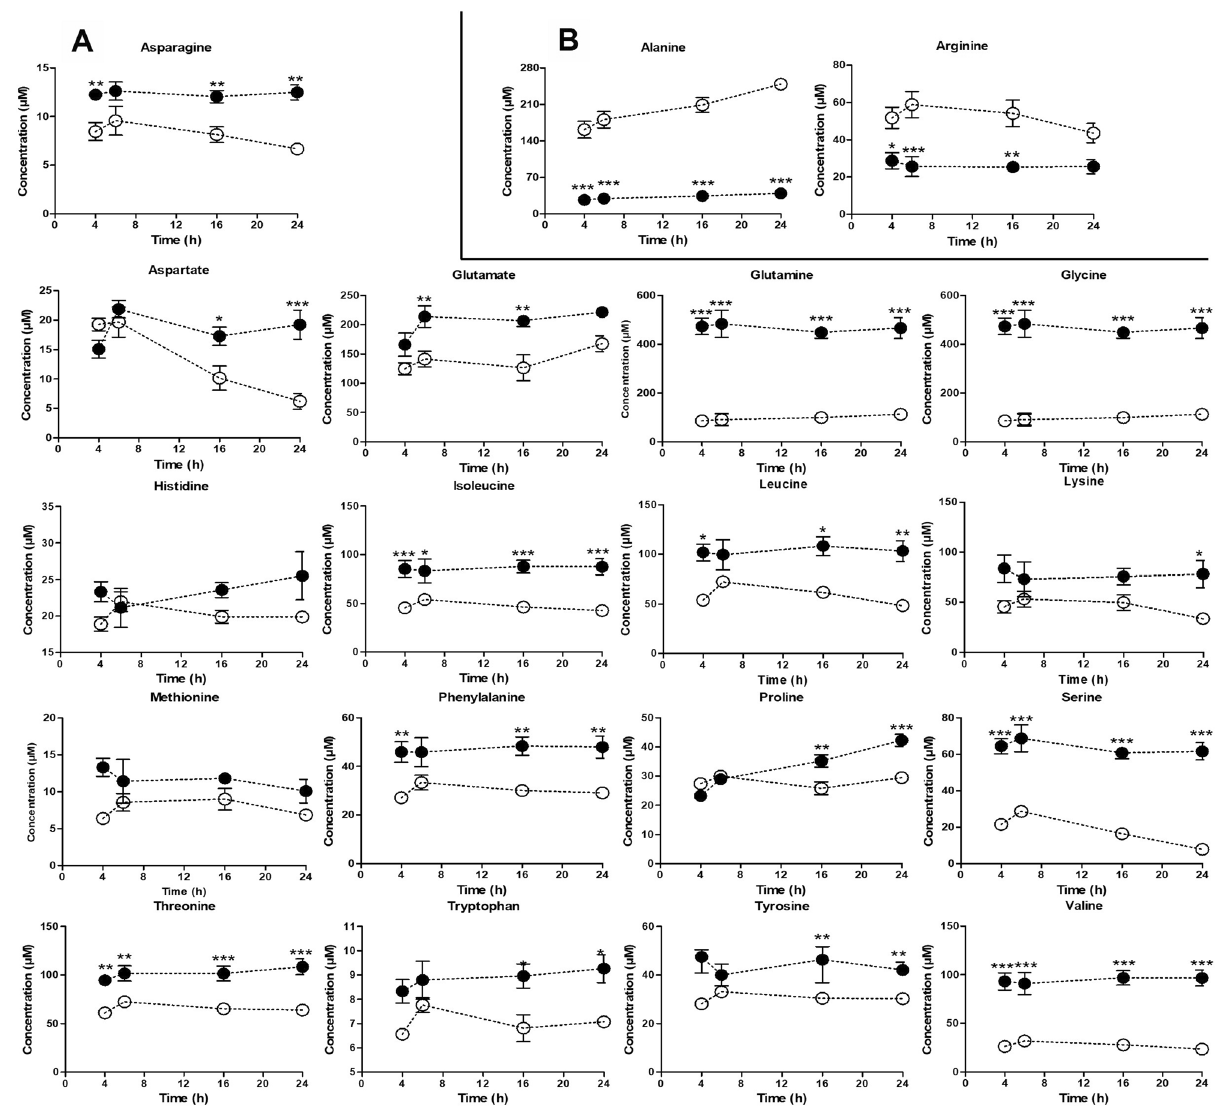
Figure 1. In vitro amino acids concentrations. ( A ) In vitro AAs downregulated in cancer cells (black circles) compared to normal breast cells (white circles). ( B ) In vitro AAs upregulated in cancer cells (black circles) compared to normal breast cells. On the horizontal axis the numbers indicate: four time points (4,6,16 and 24) within 24 h of standard cells growth. The data represent the mean ± S.E.M. of the AAs concentrations comparing MDA-MB-231 cells vs normal human breast cells. * p < 0.01, ** p < 0.001, *** p <